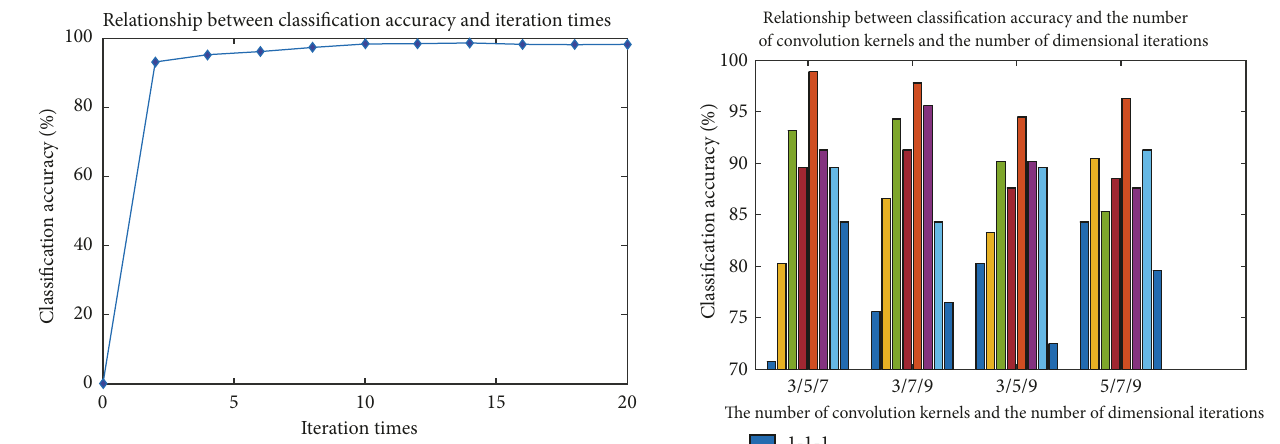
Figure 12: Relationship between classification accuracy and itera- tion times.